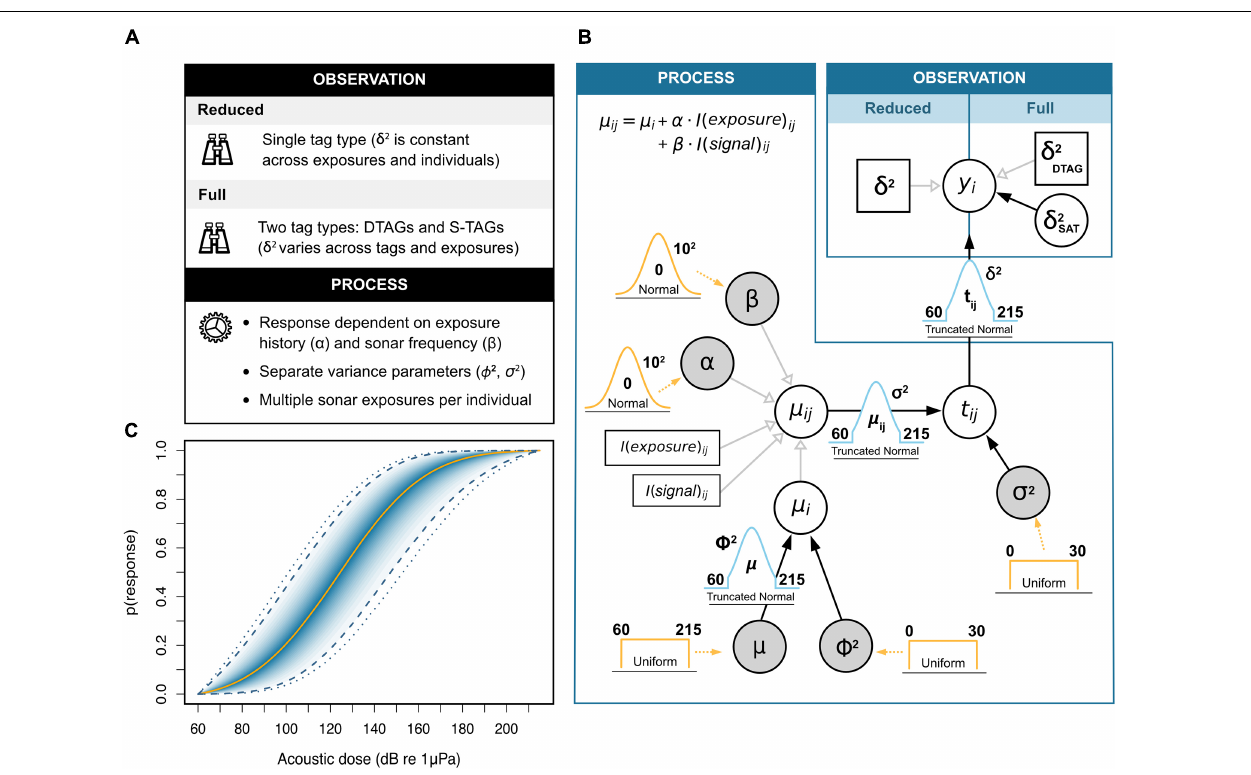
FIGURE 1 | Bayesian hierarchical dose-response model used for simulating Cuvier’s beaked whale ( Ziphius cavirostris ) responses to naval sonar. (A) Summary of features for the observation and process model components. The treatment of sampling uncertainty ( δ 2 ) defines variants of the original framework proposed by Miller et al. (2014). In the reduced model, all animals carry the same type of tag and uncertainty is treated as a constant. In the full model, different tags are fitted on different individuals, and the uncertainty associated with S-TAGs varies stochastically (see main text for details). (B) Directed acyclic graph of the model structure. The expected response threshold µ ij for the i th whale in the j th exposure session is conditional on the additive effects of two contextual covariates: the animals’ previous history of exposure (“exposure” with coefficient α ), and the frequency band of the sonar signal (i.e., low- or mid-frequency; “signal” with coefficient β ). Random variables are denoted by circles, and those monitored for posterior inference are additionally shaded in gray. Constants are represented by square boxes. Filled (black) and open (light gray) arrows indicate stochastic and deterministic relationships, respectively. Prior distributions are shown in orange, with their relevant parameters (i.e., bounds and/or mean and standard deviation) appearing in bold font. Dotted arrows indicate the parameters to which priors relate. (C) Example dose-response curve obtained from posterior estimates of model parameters. The curve maps the probability of behavioral response (y-axis) to the received sound level (i.e., acoustic dose, x-axis). The solid orange line denotes the posterior median, followed by the 5, 10, 15 ... and 95% credible intervals in darker to lighter shades of blue. Dashed and dotted lines mark the 95 and 99% credible intervals,